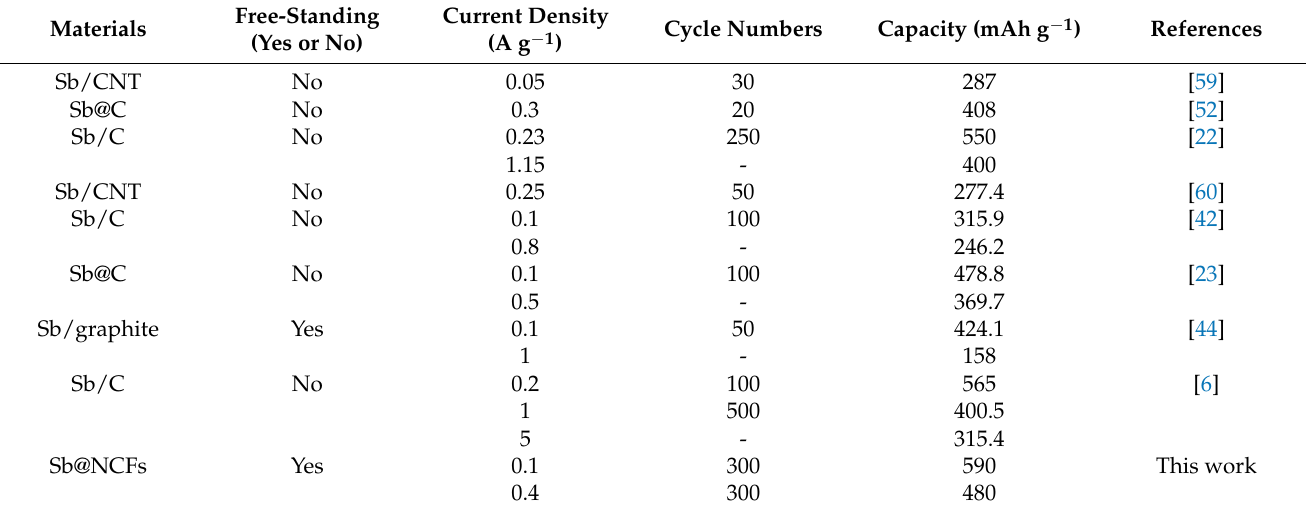
Table 1. Comparison of the electrochemical performances of the prepared Sb@NCF composites with previously reported Sb-C-based